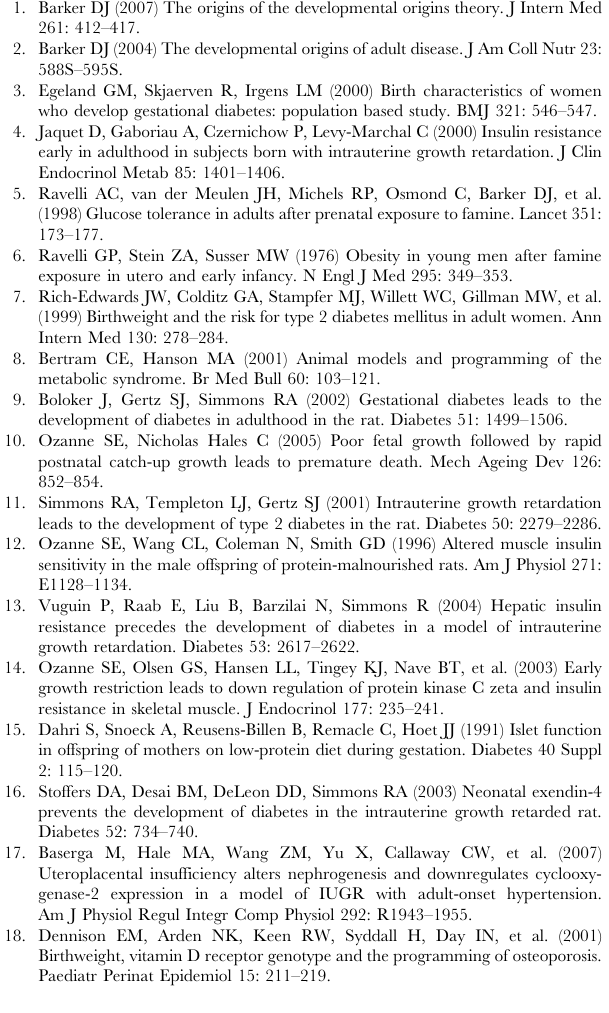
Figure S5 Technical validation studies using MassArray confirm HELP data. Four loci were identified, two each representing constitutively hypo- and hyper-methylated sites. The hypomethy- lated sites were located at chr12:63986847-63987489 and